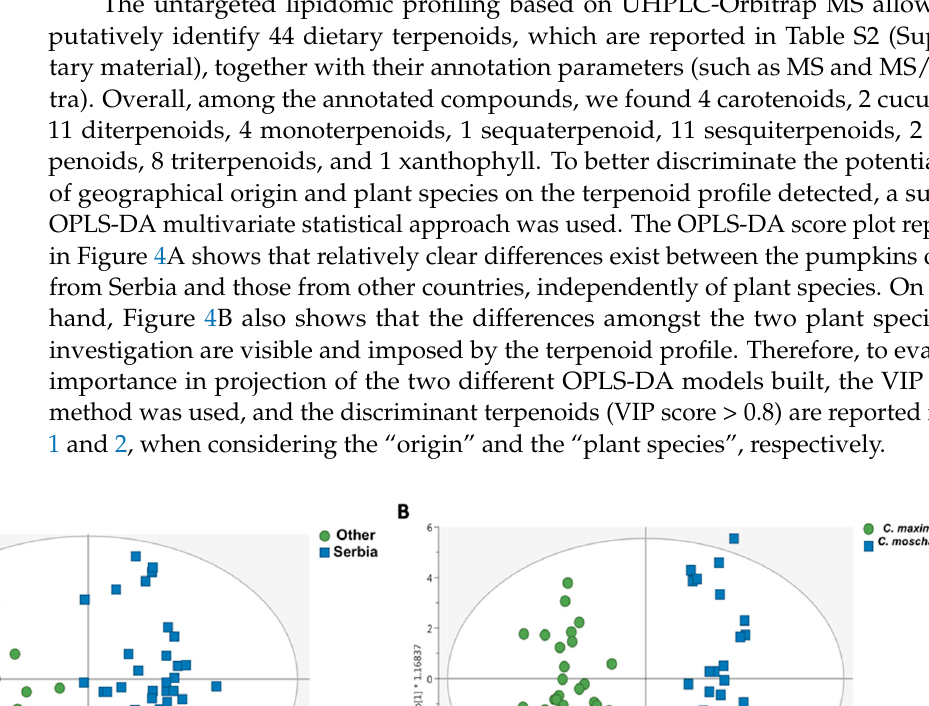
Figure 4. OPLS-DA score scatter plot obtained considering the discrimination based on the lipidomic profiles of the pump- kin samples originally from Serbia and those originating outside Serbia ( A ), and when considering the plant species ( B ), i.e., C. maxima vs. C. moschata .